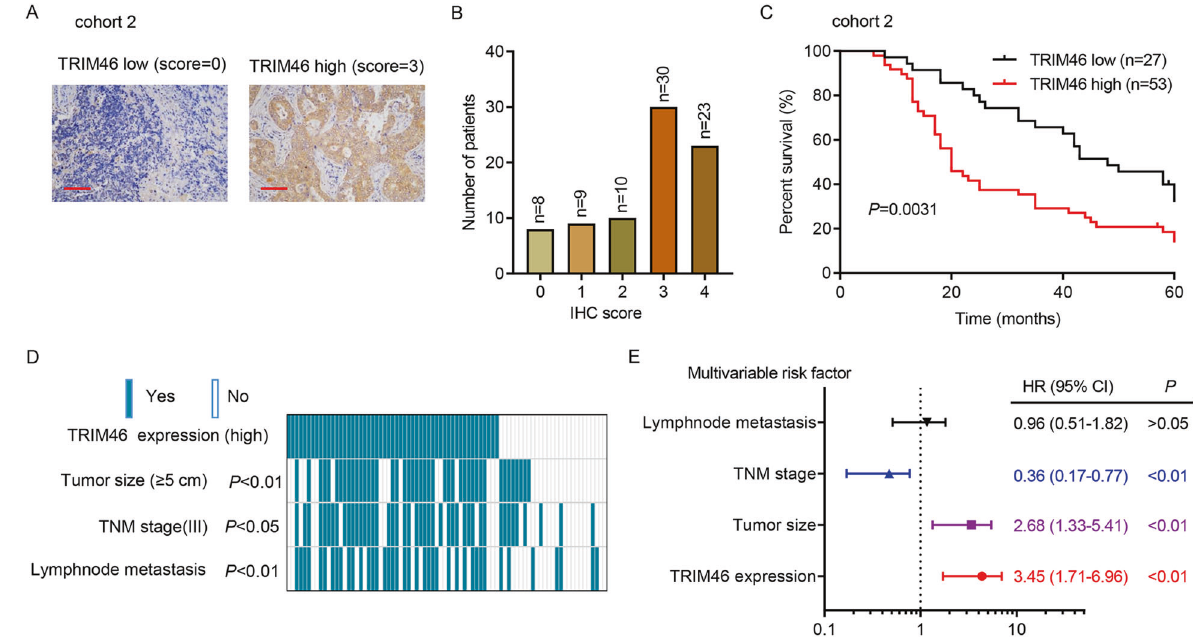
Fig. 2 The clinical relevance of TRIM46 in LUAD. A Immunohistochemical staining of TRIM46 in Shanghai Chest Hospital cohort 2 (scale bar: 100 μ m). B Immunohistochemistry score of TRIM46 in Shanghai Chest Hospital cohort 2. C Survival analysis was performed between patients with TRIM46 high- and low-expression in Shanghai Chest Hospital cohort 2 (log-rank test). D Comparing tumor size, TNM stage, and lymphnode metastasis between TRIM46 high- and low expressing tumors in the Shanghai Chest Hospital cohort 2. The heat map illustrates the association of different clinicopathologic features with TRIM46 high- and low-expression ( n = 80). E Multivariate regression analysis was applied (all the bars correspond to 95% con fi dence